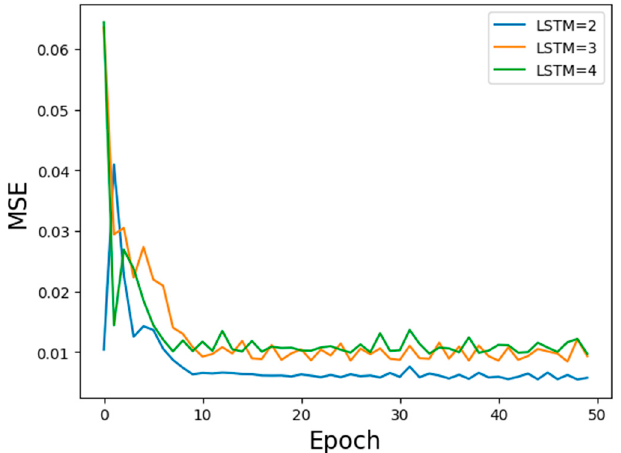
Figure 8. Comparison of LSTM layer loss.